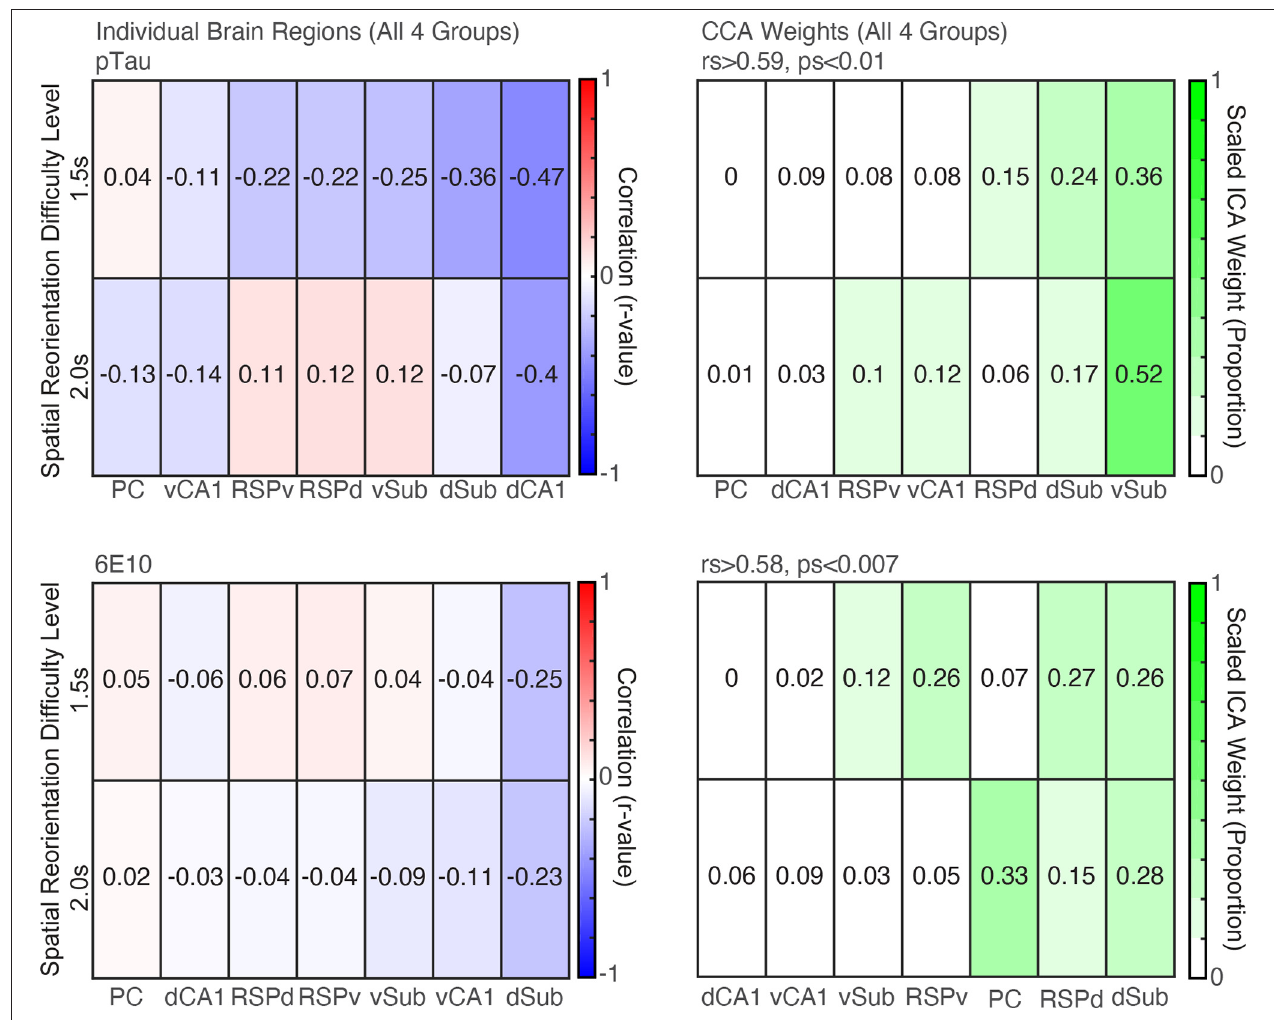
FIGURE 6 | CCA analyses revealed profiles of pTau and 6E10 densities that were significant predictors of subsequent behavior. Top . Left . Correlations between raw pTau density for individual brain region and spatial reorientation performance for the 1.5 and 2.0s difficulty levels for all four groups combined (3- and 6- month female, 6- and 12- month male). Right . Brain region weights (expressed as a proportion) identified by Canonical Correlation Analysis (CCA) for the linear combination that was significantly correlated with spatial reorientation performance for the 1.5 and 2.0s difficulty levels for all four groups. Bottom . Left and Right . Same as Top Left and Right , except for 6E10